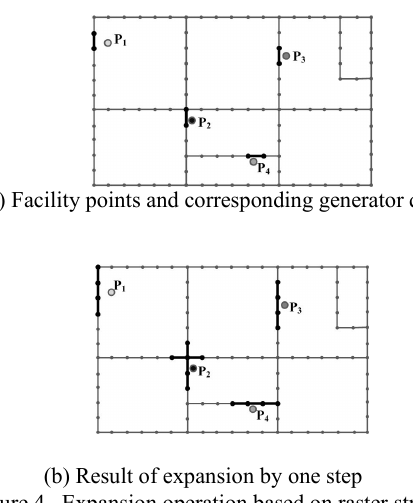
Figure 4. Expansion operation based on raster structure of network.